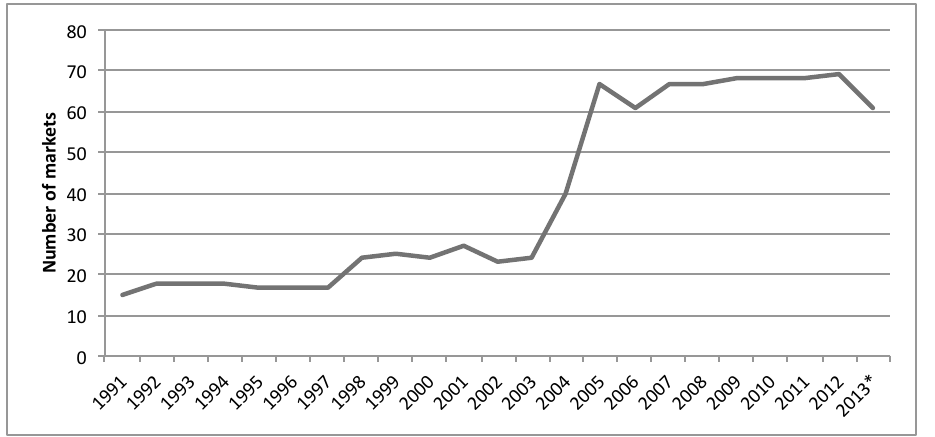
Figure 1. Number of maize markets with at least one observation made each year